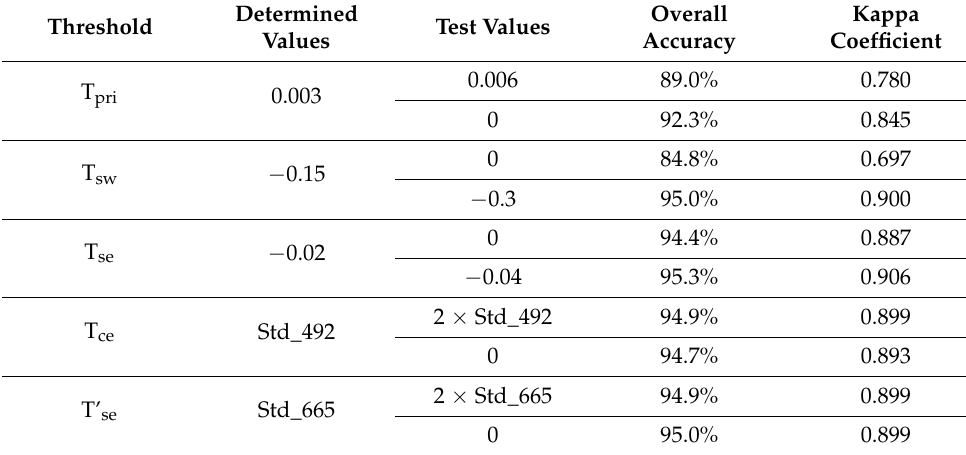
Table 4. Pumice extraction performance from the threshold sensitivity analysis. The algorithm performance using determined threshold values from this study has an overall accuracy of 95.5% and a kappa coefficient of